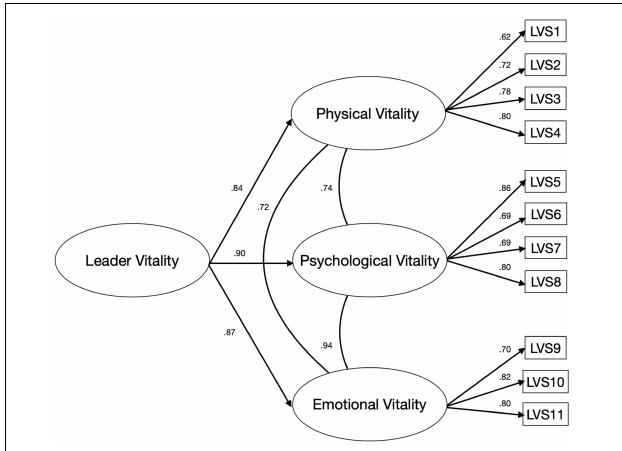
FIGURE 2 | Graphical representation of a three-factor model with a higher-order factor.